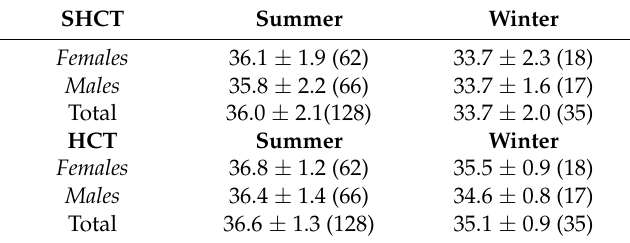
Table 2. Comparison of SHCT and HCT between the summer and winter for adults of Halobates sericeus ( H.s. ). SHCT: temperature at which semi-heat coma occurred; HCT: temperature at which heat-coma occurred [Mean ± SD(n)]. Specimens were collected 1–14 September 2010 during the science cruise, KH-10-04-Leg 1 (summer) and 26 February–1 March 2012, during the science cruise, KH-12-01-Leg 2 (winter). SHCT Summer Winter